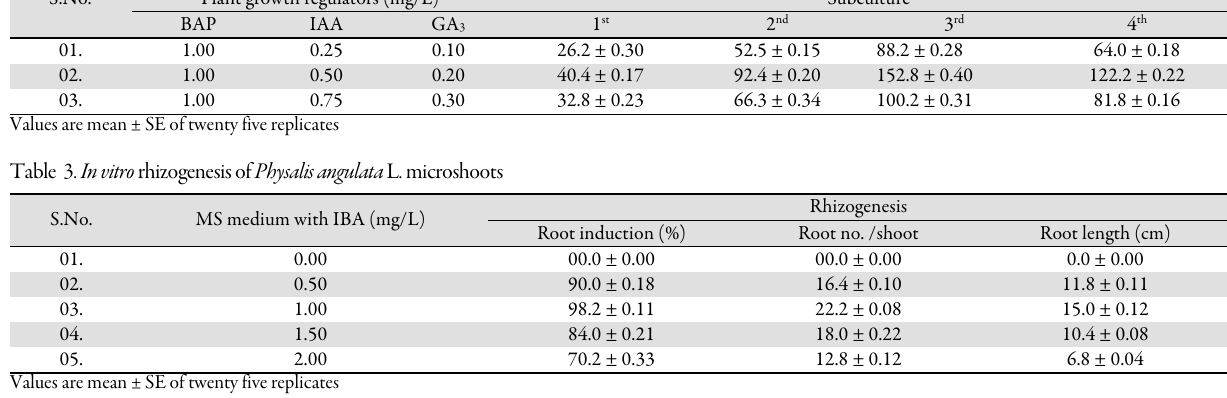
Table 2. Proliferation of multiple shoots of Physalis angulata L. at different subcultures S.No.